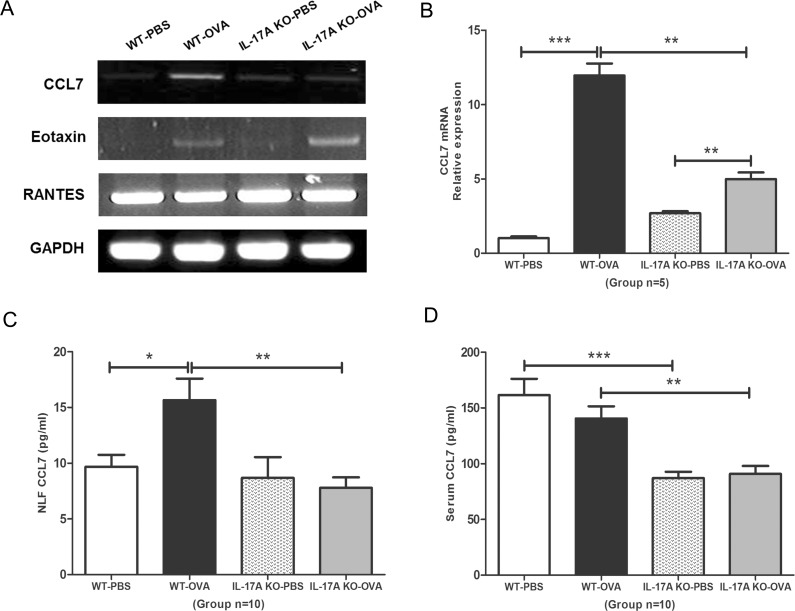
Comparison of CCL7 mRNA and protein expression levels.(A) The mRNA levels of a variety of chemokines associated with eosinophil chemotaxis, including eotaxin, RANTES, and CCL7 were measured by Reverse Transcription polymerase chain reaction (RT-PCR). (B) Quantitative polymerase chain reaction (qPCR) was performed to measure CCL7 mRNA levels (n = 5) in the nasal mucosa. CCL7 protein levels were measured by enzyme-linked immunosorbent assay in (C) nasal lavage fluid and (D) serum (n = 10). Results are means ± SEM (*** P < 0.001, ** P < 0.01, * P < 0.05). Fig 4A and 4B are representative results from at least two independent experiments.